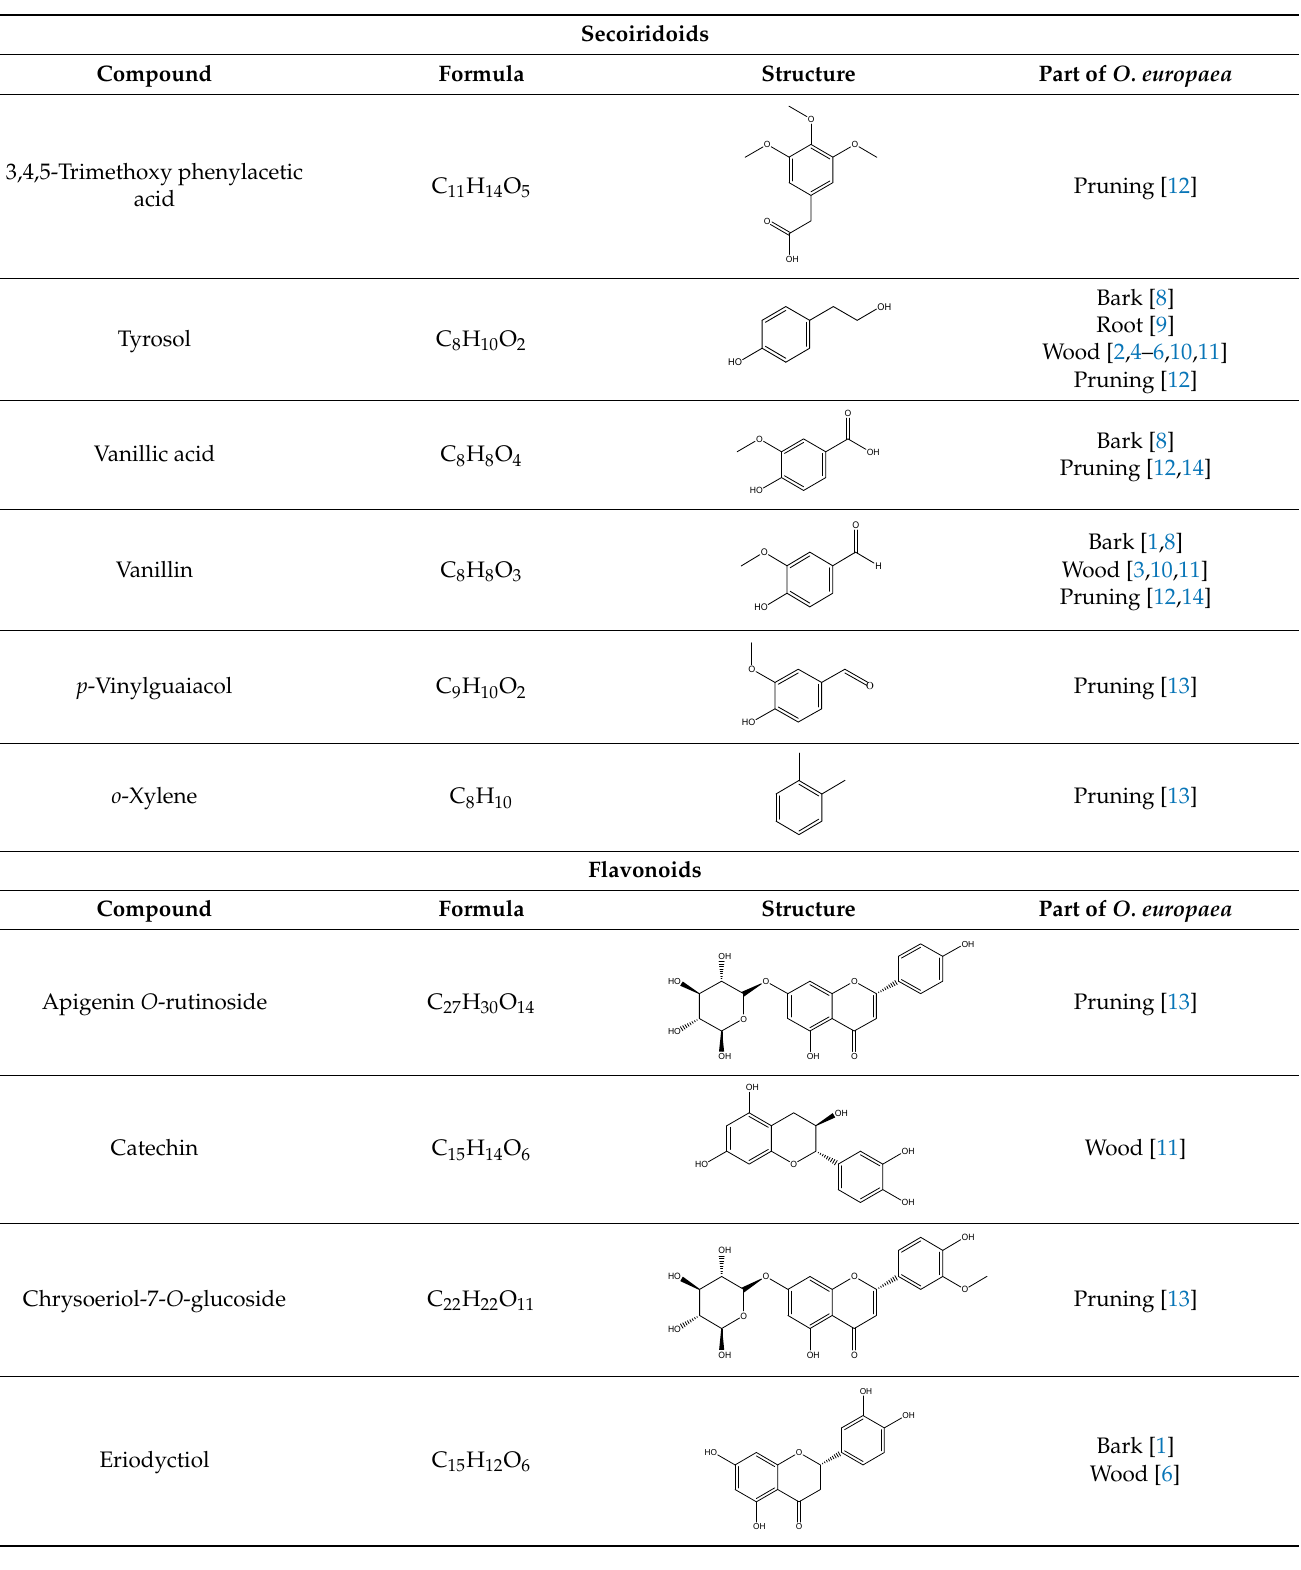
Table 1. Cont. Secoiridoids Formula Structure Part of O.